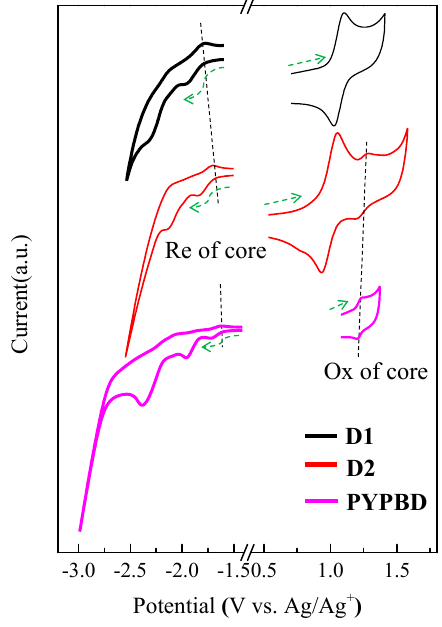
Figure 7. CV curves of the redox of D1 , D2 and PYPBD (arrow: scan direction).